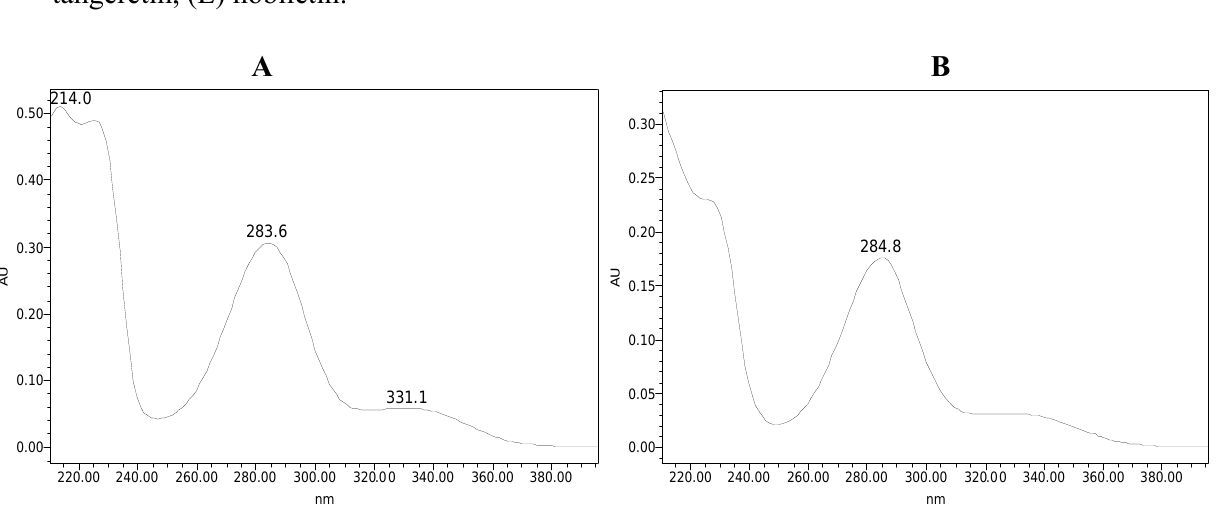
Figure 4. Photodiode array UV spectra: (A) naringin, (B) hesperidin, (C) didymin, (D) tangeretin, (E)